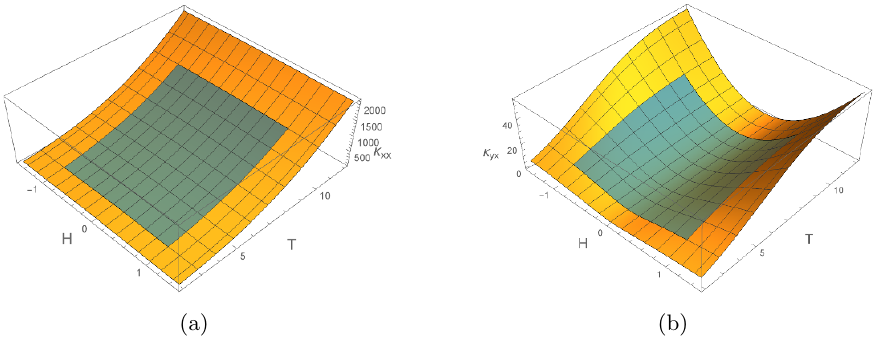
Figure 21 . The temperature and the magnetic (cid:12)eld dependence of (a) parallel, (b) transverse thermal conductivity.